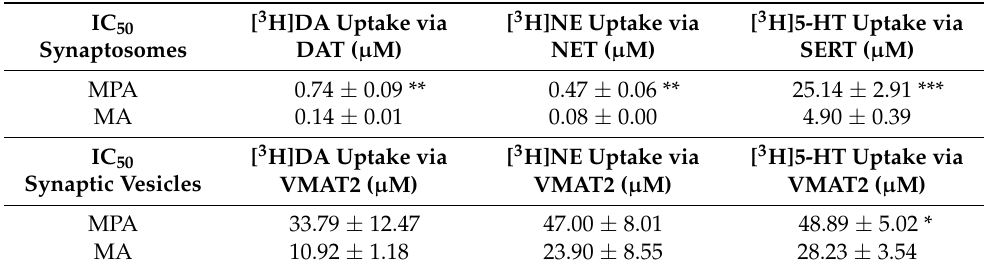
Table 1. Effects of methiopropamine (MPA) and methamphetamine (MA) on uptake of [ 3 H]DA,